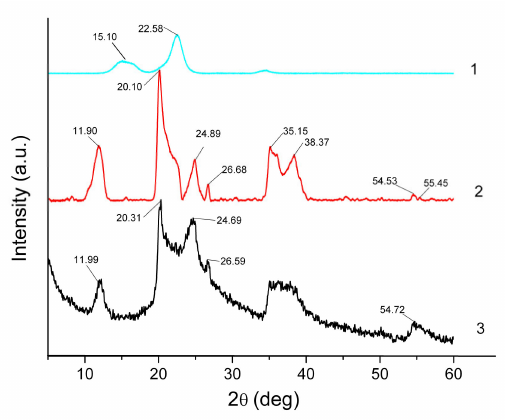
Figure 2. XRD patterns of MCC ( 1 ), Hal ( 2 ) and IL/Hal/MCC-1 ( 3 )